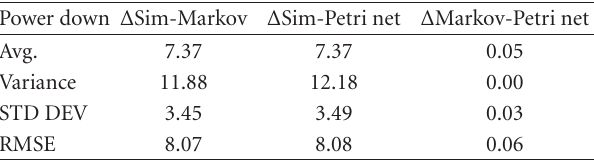
Table 4: Δ Energy (Joules) estimates ( P ow e r Up De lay = 0 . 001 second).